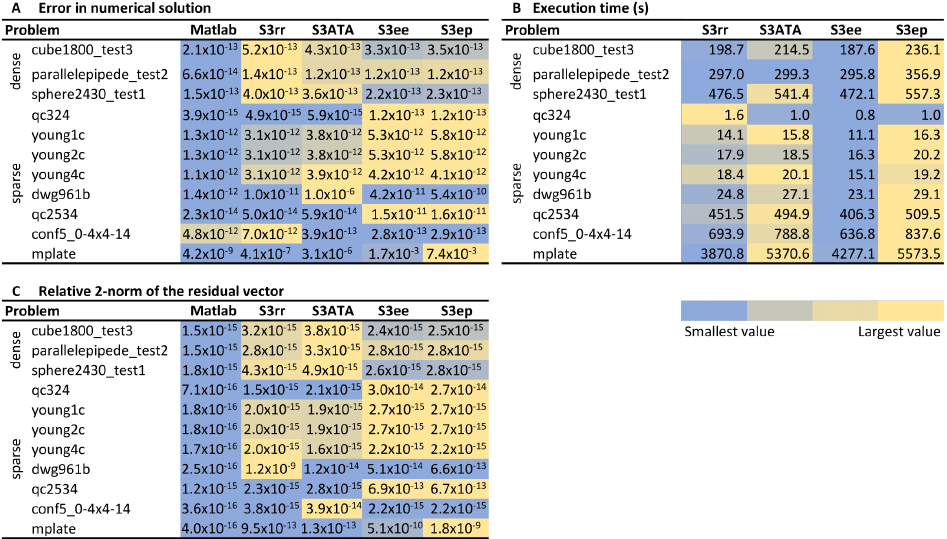
Figure 9. Comparative analysis of the performance of the four variants of the orthogonally scaled complex ABS algorithm and the mldivide ( \ ) algorithm of Matlab on real-life problems. Panel ( A ) shows the computational accuracy. Panel ( B ) shows the execution times for our ABS-based variants in seconds. Panel ( C ) shows the relative 2-norm of the residual vector ( (cid:107) b − Ax n (cid:107) 2 (cid:107) b (cid:107) 2